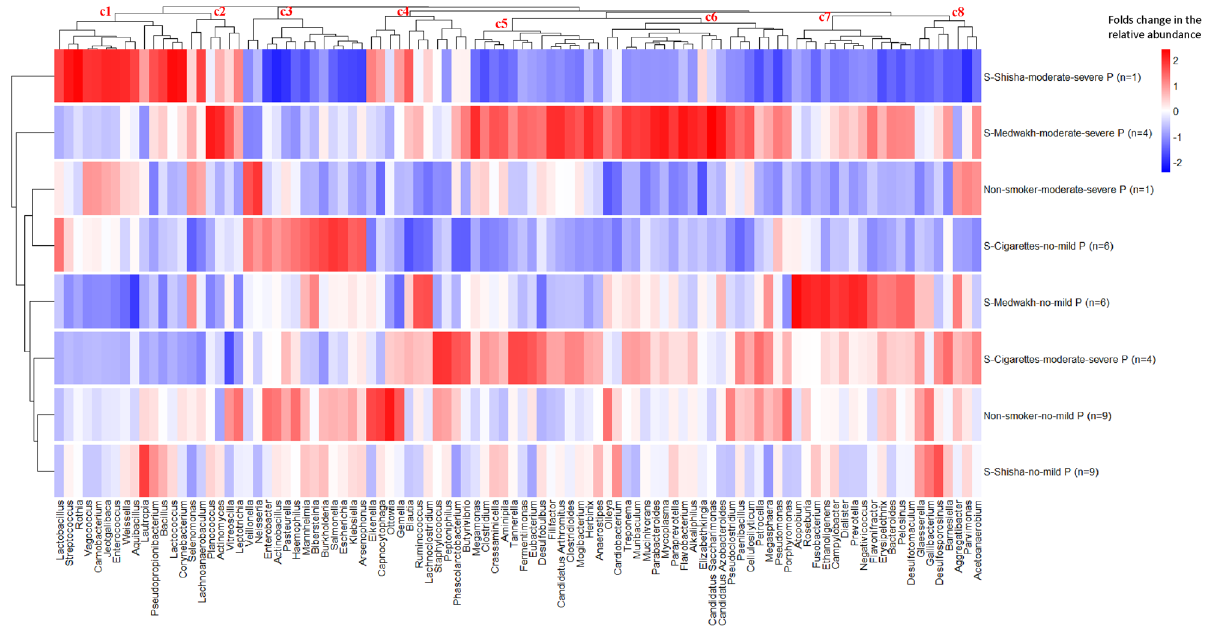
Figure 3. Distribution of different genera (relative abundance > 0.01%) grouped by smoking status and periodontal condition. Relative abundances of genera were ranked based on group counts (scaled across columns). Red color indicates high abundance in a particular group and blue color indicates low abundance. Dendrograms show clustering based on the relative abundance of different genera (left dendrogram: group clustering; top dendrogram: clustering of genera based on abundances in all the